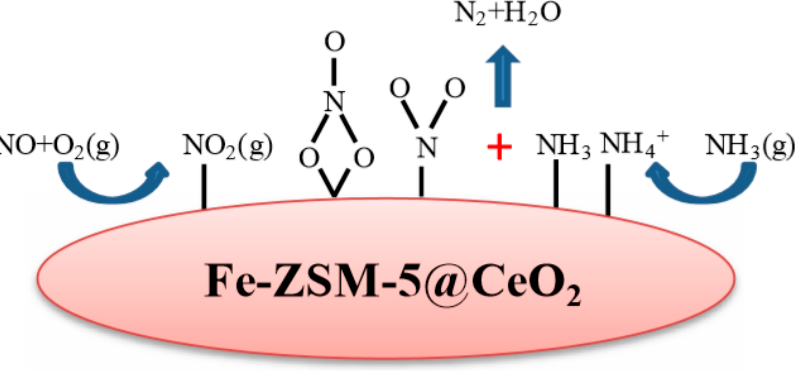
Figure 21. The proposed mechanism of NH 3 -SCR over Fe–ZSM-5@CeO 2 [118].